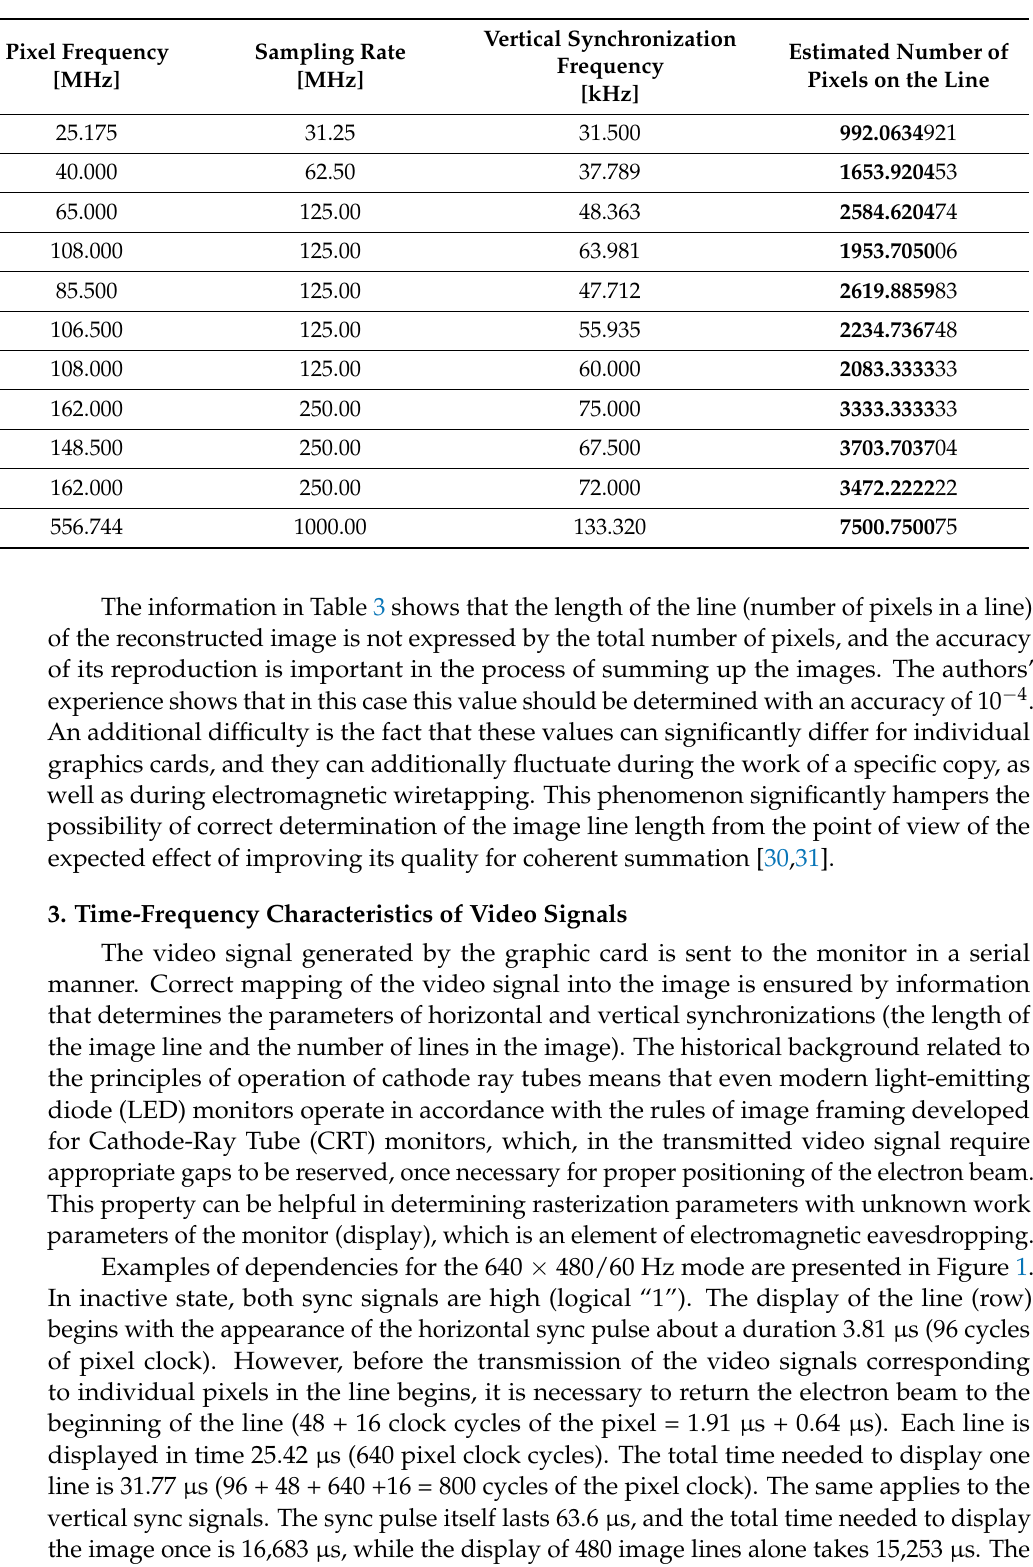
Table 3. Rasterization parameters in the case of signal recording by using an ADC